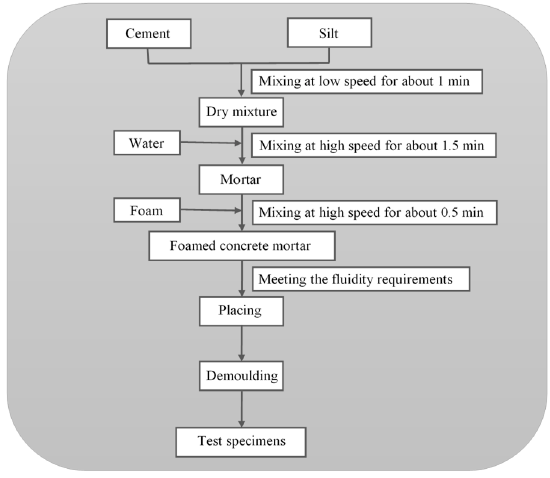
Figure 2. Procedure of preparation of foamed concrete.